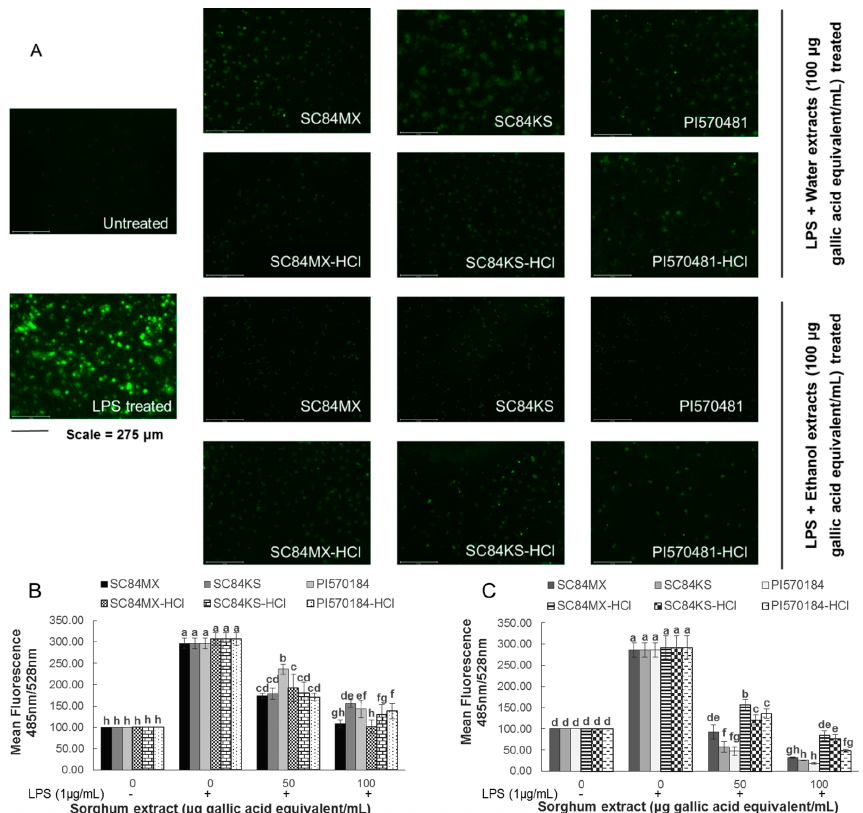
Figure 4. ( A ) Fluorescence microscopy analysis of reactive oxygen species (ROS) production in LPS-induced macrophages as a ff ected by treatment with sorghum water and ethanol extracts (100 µ g gallic acid equivalent / mL), pictures were taken at 10 × magnification with a scale bar of 275 µ m. Mean fluorescence values of ROS that were a ff ected by sorghum ( B ) water and ( C ) ethanol extracts in LPS-induced macrophages were quantified by fluorescence spectrophotometry and were expressed with respect to the negative control. Error bars are standard deviations ( n ≥ 3). Di ff erent letters above columns indicate significant di ff erences ( p <